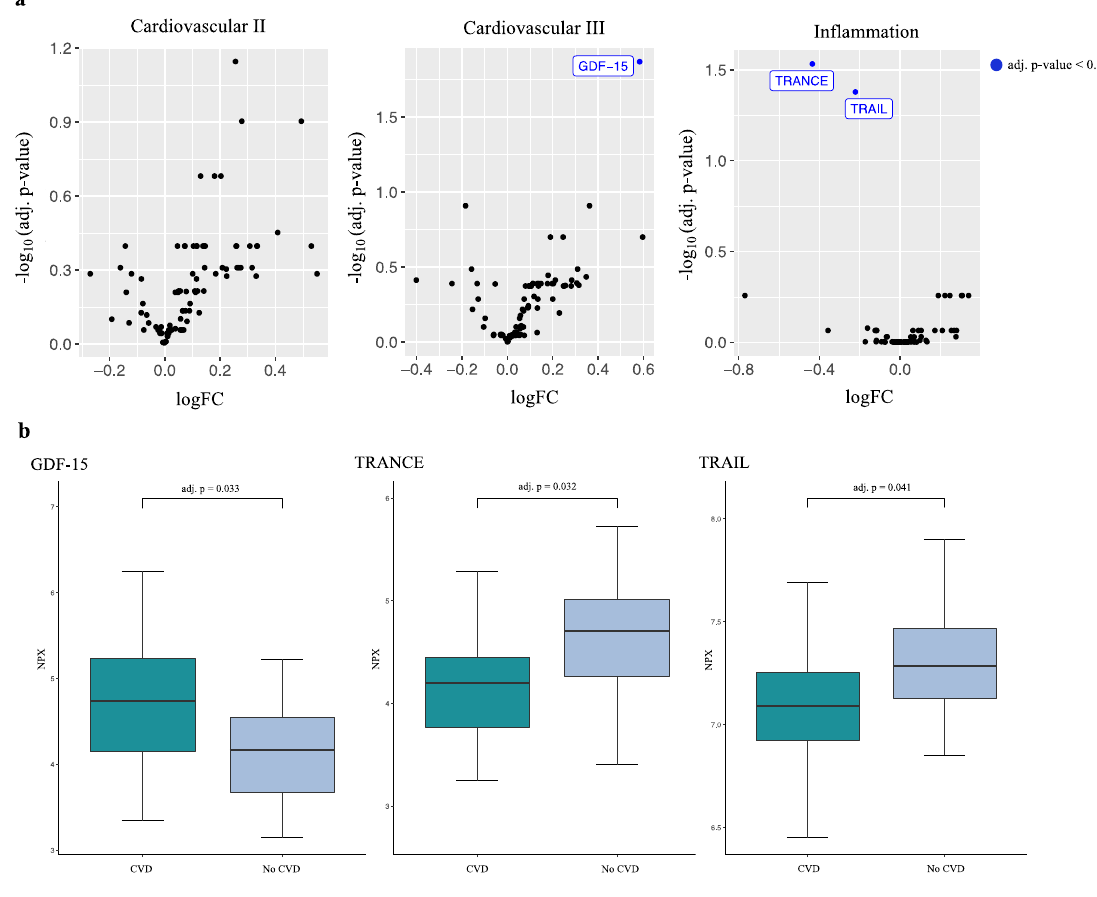
Figure 1. Differentially expressed proteins associated with cardiovascular disease in patients with psoriasis. ( a ) Volcano plots and ( b ) box plots for differentially expressed proteins assessed by proteomic panels Cardiovascular II and III, and Inflammation (Olink Bioscience, Uppsala, Sweden) in patients with psoriasis with or without cardiovascular disease (n = 85). GDF-15 growth differentiation factor-15, TRANCE tumor necrosis factor-related activation-induced cytokine, TRAIL tumor necrosis factor-related apoptosis-inducing ligand, CVD cardiovascular disease, NPX normalized protein expression, adj. p adjusted p-value for false discovery rate. LogFC (fold change) is reported in log 2